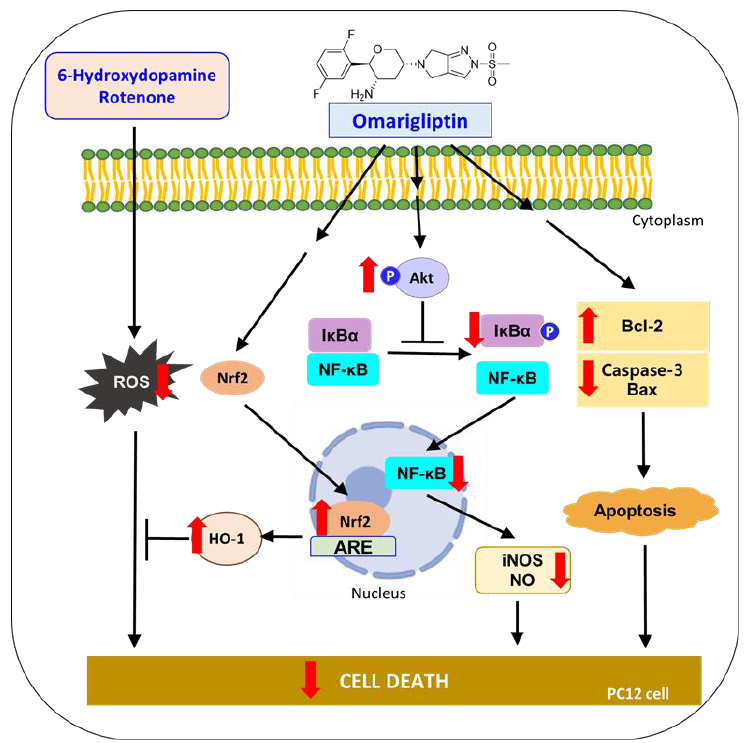
Figure 10. Suggested molecular mechanisms underlying the neuroprotective effects of OMG in PC12 cells. 6-OHDA, 6-hydroxydopamine; ROS, reactive oxygen species; Nrf2, nuclear factor erythroid 2–related factor 2; HO-1, heme oxygenase-1; IκBα, inhibitory kappa Bα; NF-κB, nuclear factor-kappa B; iNOS, inducible nitric oxide synthase; NO, nitric oxide; Bcl-2, B-cell lymphoma 2; Bax, Bcl-2-associated X.